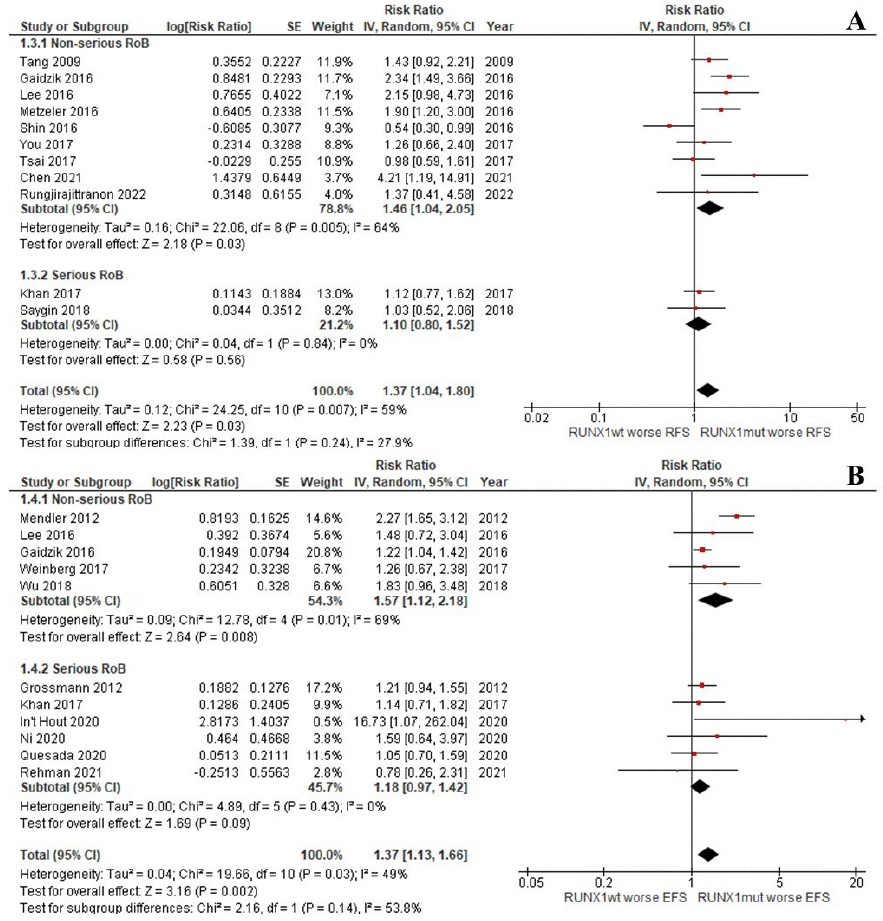
Figure 3. Forest plot of the clinical outcomes of the RUNX1 mut and RUNX1 wt AML patients: ( A ) RFS; ( B ) EFS.